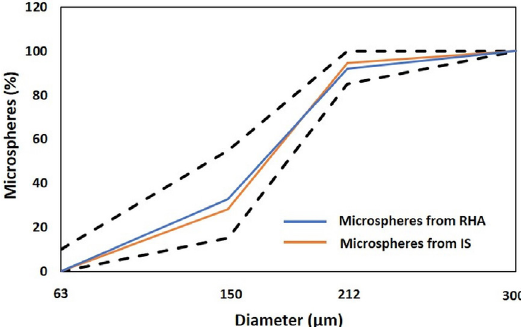
Figure 3. Evaluation of the diameter of the microspheres compared to the limits of the Brazilian standard (black lines) for Premix-type microspheres.